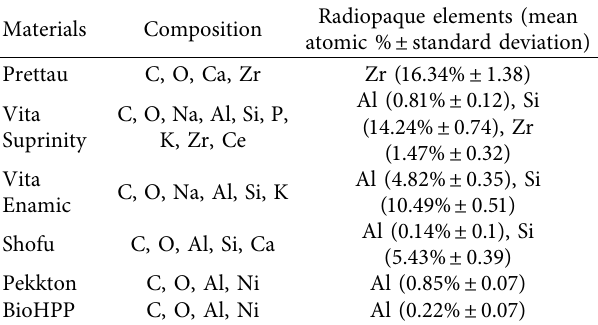
Figure 3: MGVs in pixels of tested CAD/CAM restorative materials compared to enamel, dentin, and Al-SW. Table 3: The compositional analysis with EDX of CAD/CAM restorative materials (mean atomic % values ± standard